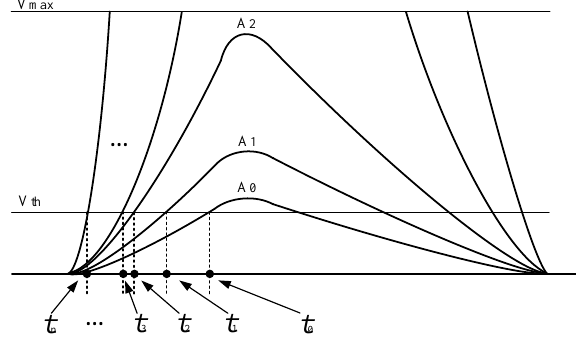
Figure 3. The principle of LED based on multiple amplification In order to obtain the minimum timing within the allowable range of error, Based on the study of X , the inline